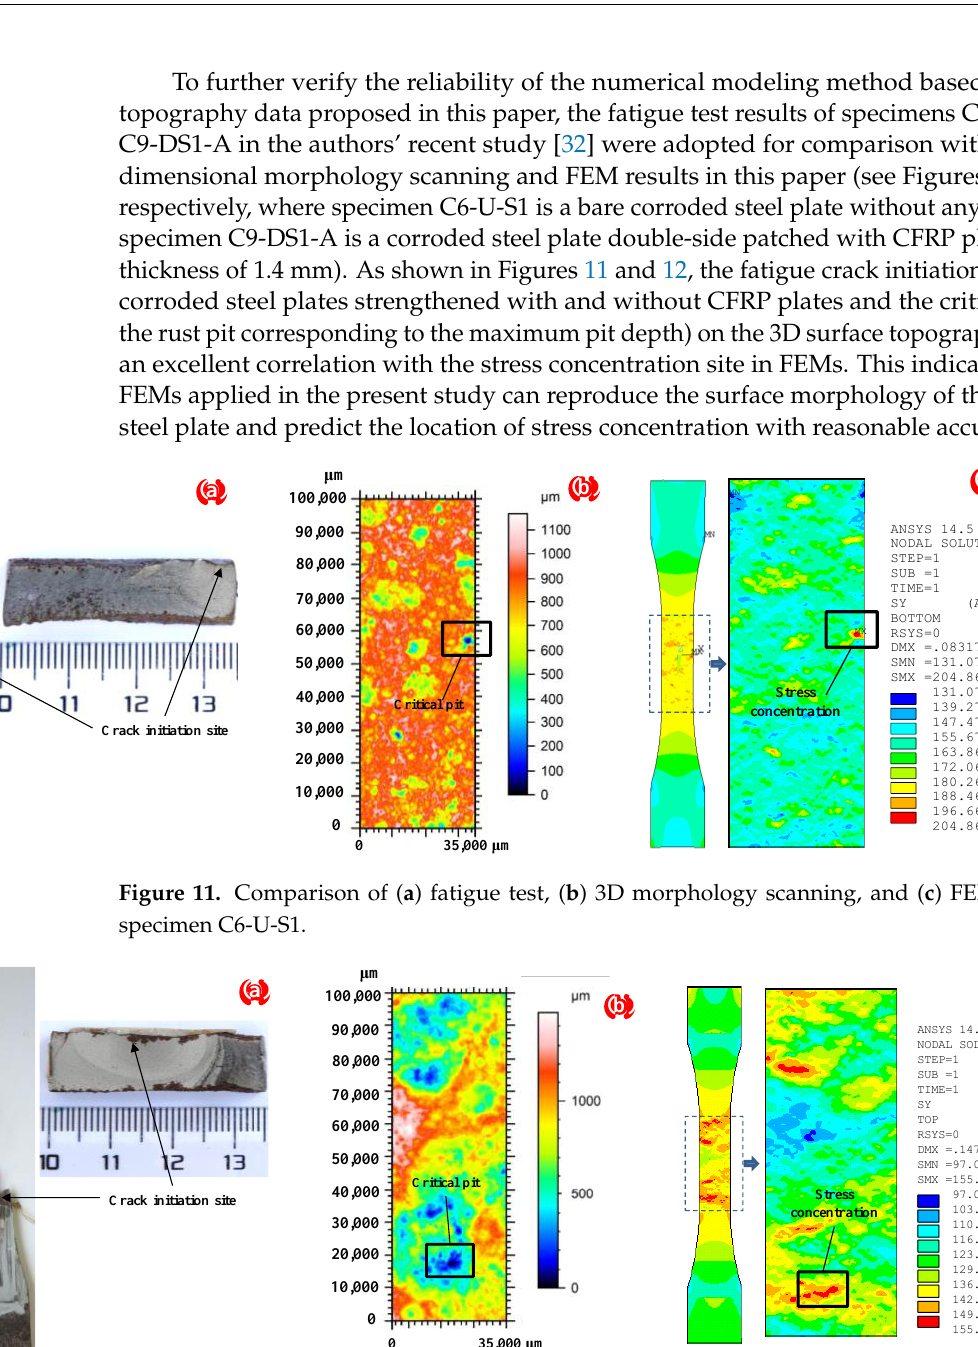
Figure 10. Variation of stress concentration factor with respect to element number.